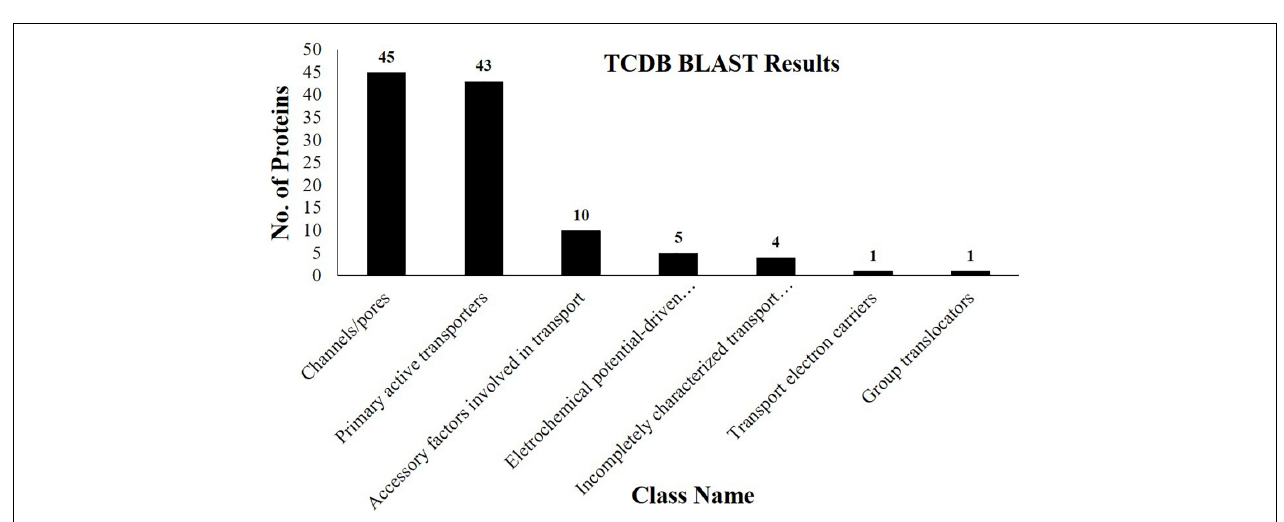
FIGURE 3 | Column graph showing the catalytic types of peptidases identified from the embryo of J. curcas seeds in accordance to MEROPS database.